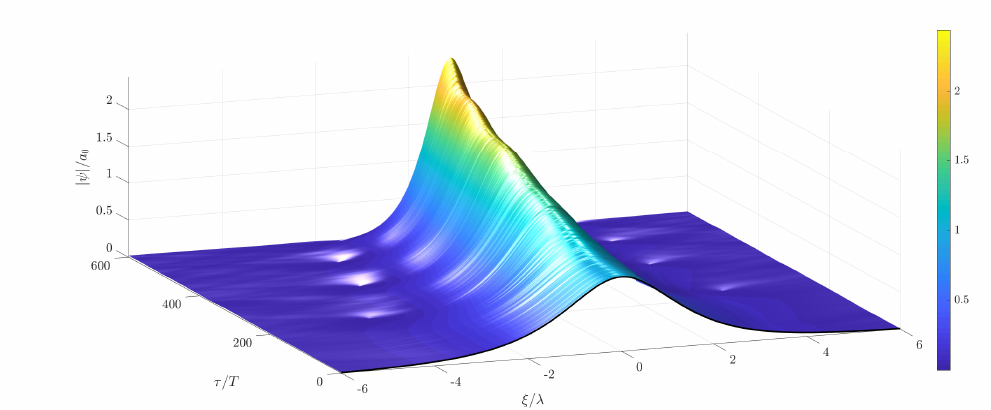
Figure 14. Temporal evolution of a soliton solution of the stochastic MNLS with non-white noise excitation in time, mean wind velocity V m = 14 m/s and σ v = 10 m/s.